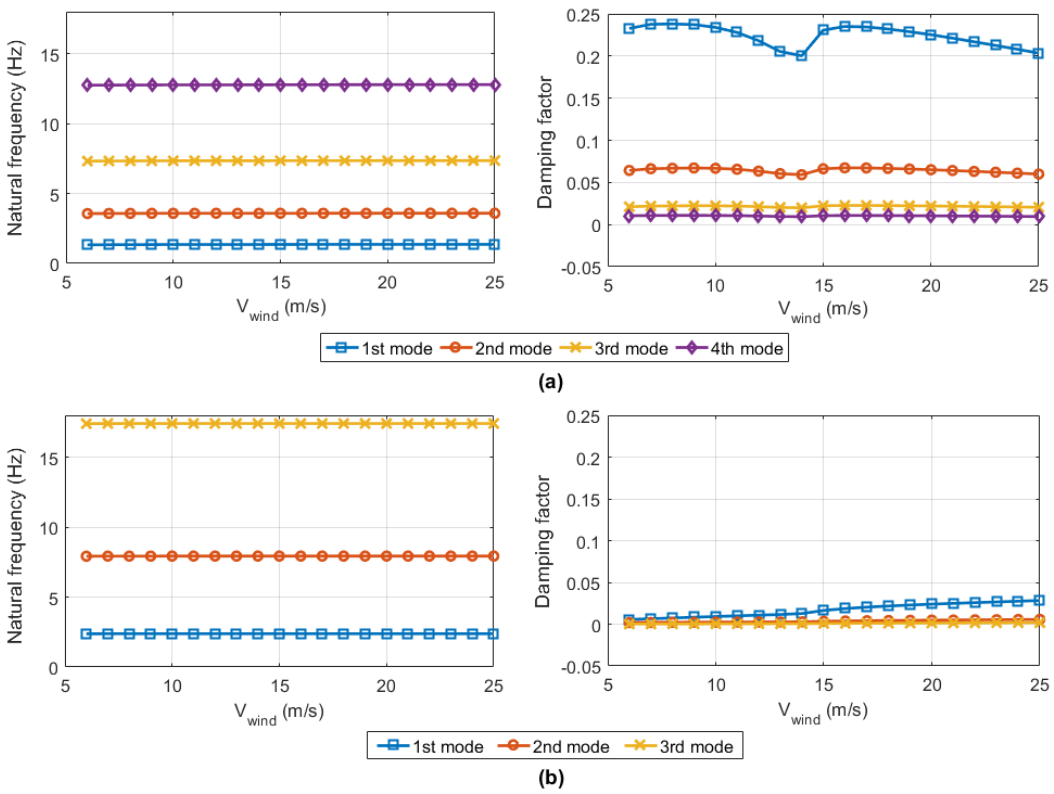
Figure 14. Aeroelastic natural frequencies and damping factors of the Tjaereborg 2-MW wind turbine blade: ( a ) Flapwise vibration modes; ( b ) Edgewise vibration modes